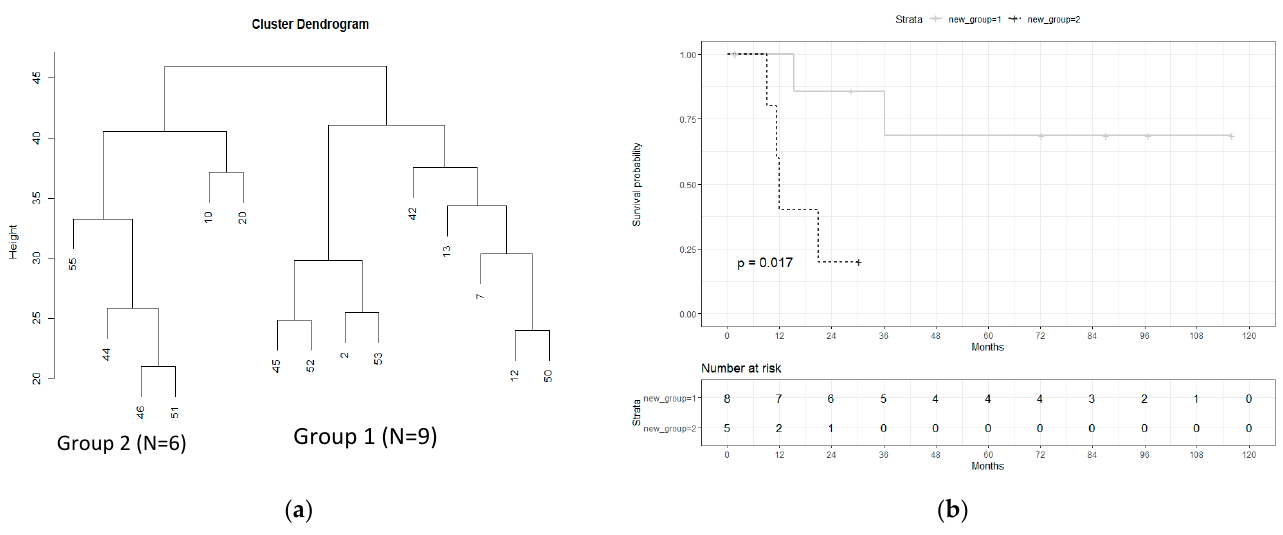
Figure 2. Subgroup analysis of the TP53mut group only. ( a ) Unsupervised hierarchical clustering of the TP53mut samples of which mRNA data was available ( n = 15). ( b ) Kaplan − Meier curves and log rank test of the overall survival of the two groups identified by hierarchical clustering ( n = 13, follow-up data of 2/15 cases were not available).